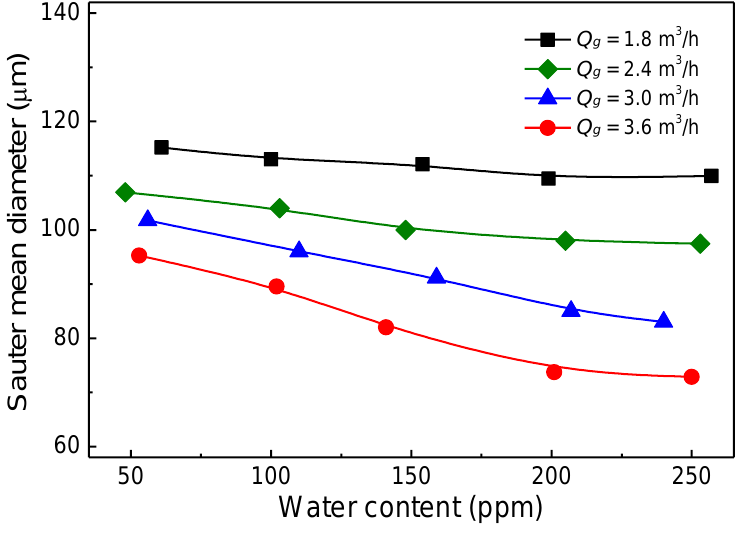
Figure 7. Sauter mean diameter of water droplets in gasoline pipe